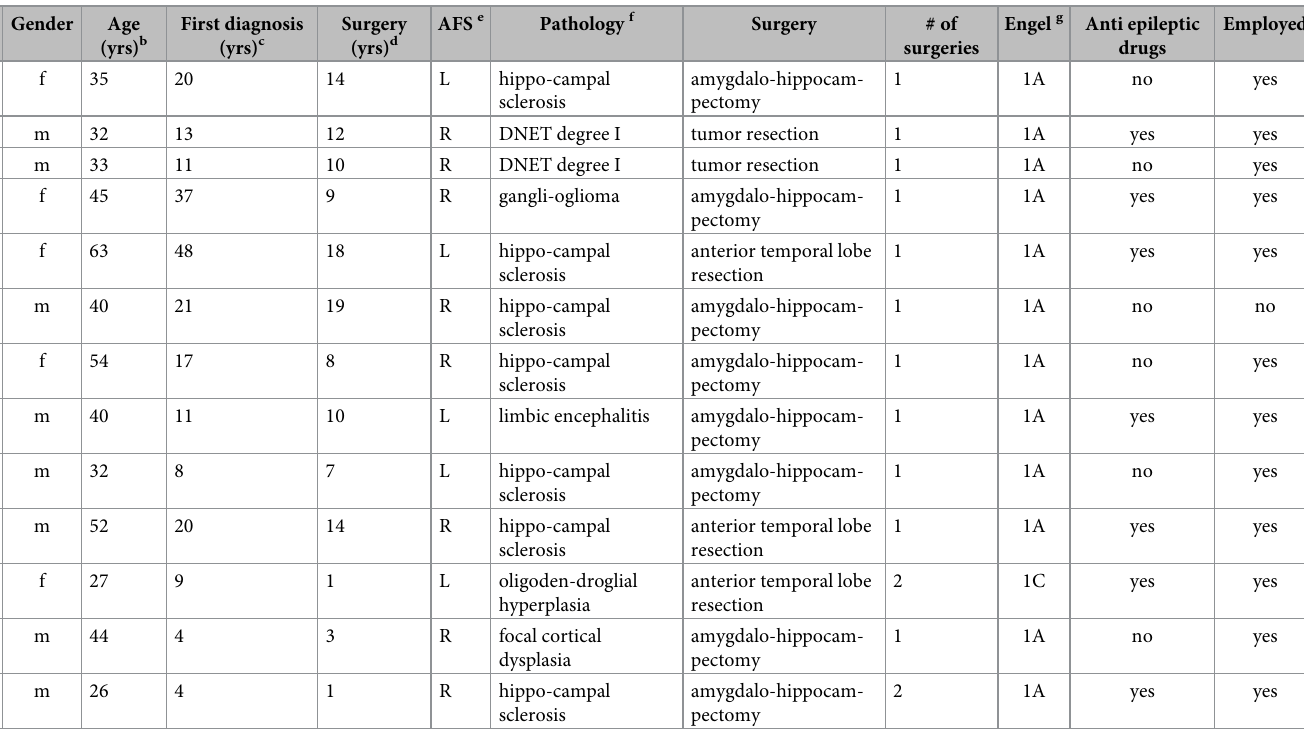
Table 1. Clinical characteristics of the